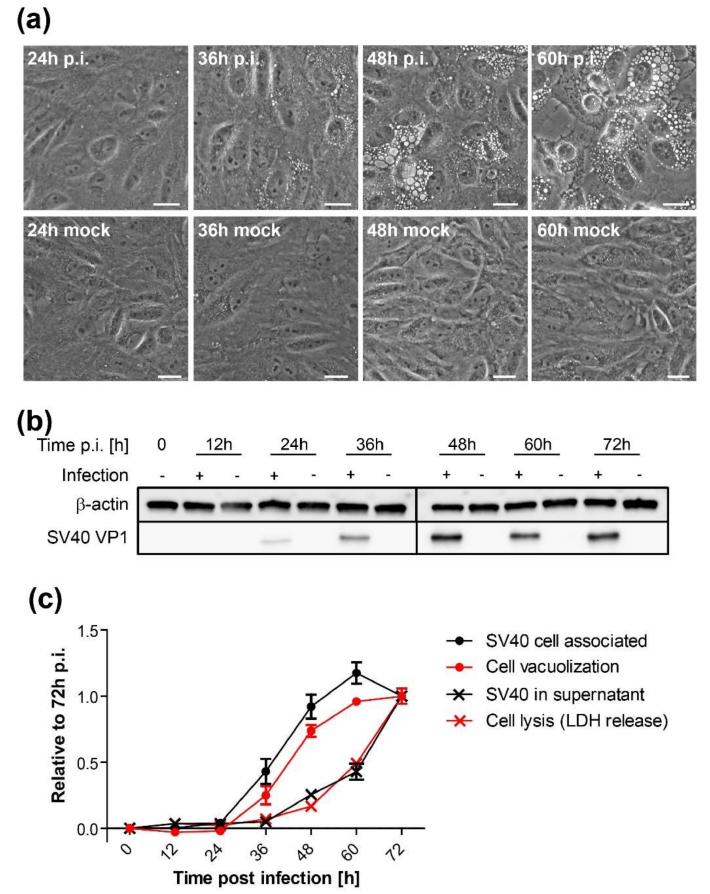
Figure 4. SV40-induced vacuole formation precedes cell lysis and virus release: ( a ) Time series of vacuole formation after infection of CV-1 cells with wildtype SV40 at an MOI of 10 and mock-treated CV-1 cells. Vacuolization was monitored by bright-field microscopy at the indicated h.p.i. Scale bar, 20 µ m; ( b ) Western blot analysis of VP1 and actin expression in mock- and SV40-infected CV-1 cells at the indicated times p.i. Mock-infected cells at each time point were used as control; ( c ) Quantitation of vacuolization, cell-associated SV40, cell lysis, and SV40 release over the time course of an SV40 infection: CV-1 cells were infected and the number of vacuolated cells at di ff erent time points after infection was quantified from bright-field images as depicted in ( a ). A minimum of 200 cells per sample and three independent experiments were analyzed. Relative infectious units of cell-associated SV40 and released SV40 were quantified from cell lysates and supernatant, respectively, by titration onto CV-1 cells and flow cytometry analysis of large T antigen. CV-1 cell lysis was determined by quantitation of lactate dehydrogenase (LDH) in the supernatant using a colorimetric enzymatic assay, in which di ff erences in the optical density between SV40-infected cells and mock-infected controls were determined. All values are displayed relative to 72 h.p.i. Mean ± SEM from three independent experiments are